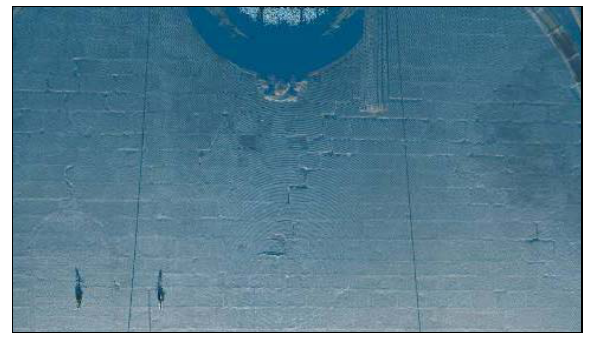
Figure 14. Track of the cracks in the eastern